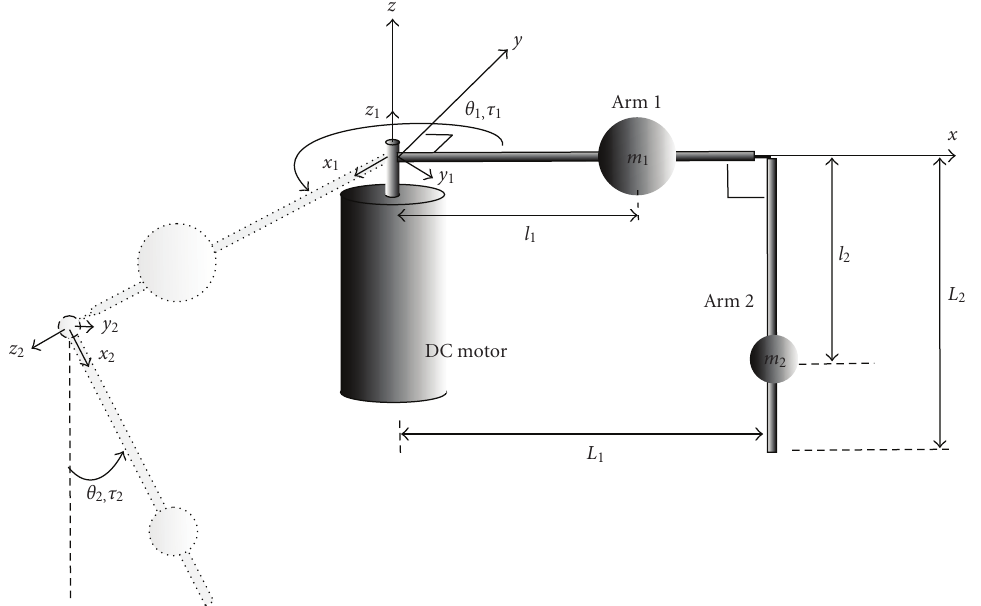
Figure 1: Schematic of the single rotary inverted pendulum